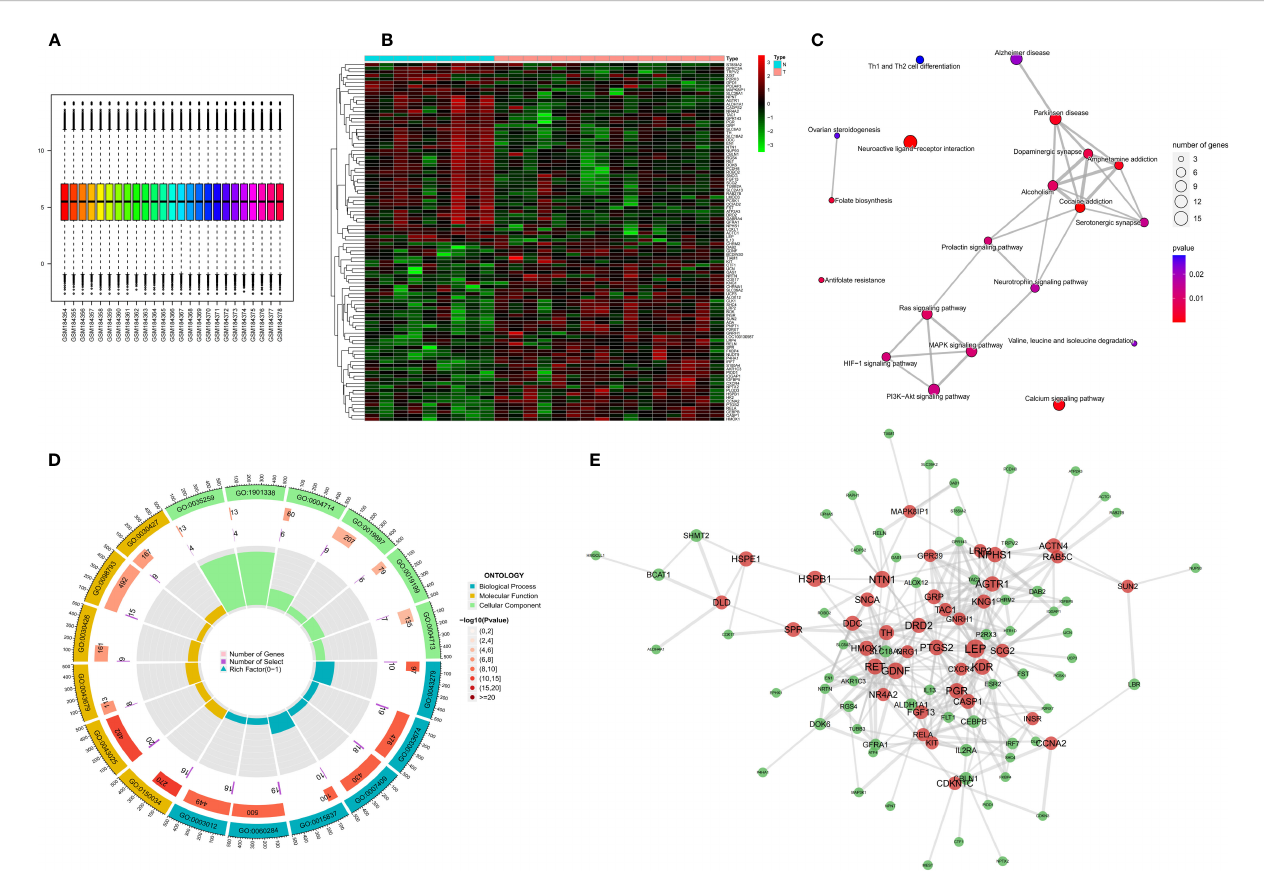
FIGURE 2 Expression of differential NFRGs in Parkinson ’ s disease, enrichment analysis, and construction of protein interaction network. (A) Box line plot of the GSE7621 dataset samples corrected for batch-to-batch differences after removal. (B) Heat map showing the expression of all DEGs in Parkinson ’ s samples. (C) Network diagram of KEGG enrichment analysis. (D) Circle diagram of GO enrichment analysis. (E) Interaction plots of proteins. Red represents hub